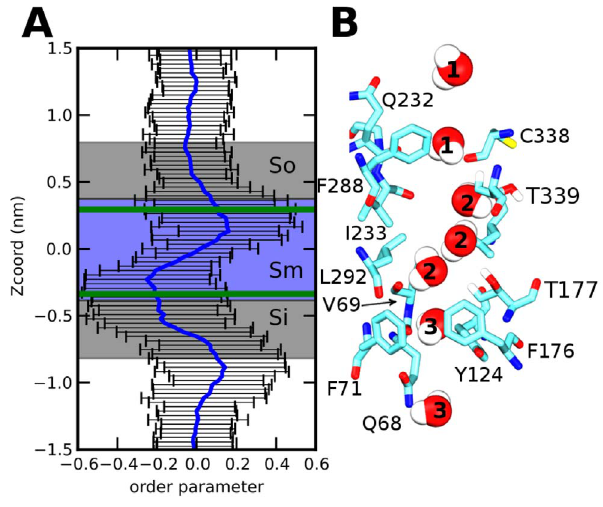
Figure 7. Orientation of water molecules through the pore. (A) Order parameter of water molecule through the pore with standard deviation (B) Different positions adopted by a mobile water molecule, crossing the pore. Green lines, same definition as Fig. 6.